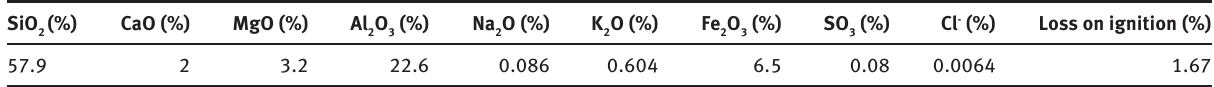
Table 7: Chemical composition of BA